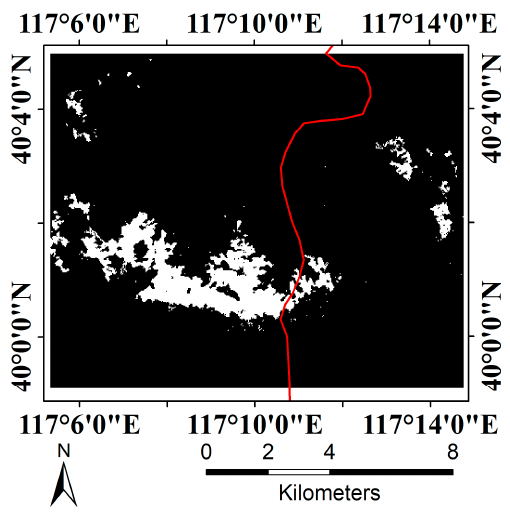
Figure 9. The study area is split into two regions according to the boundary between Hebei and Tianjin.